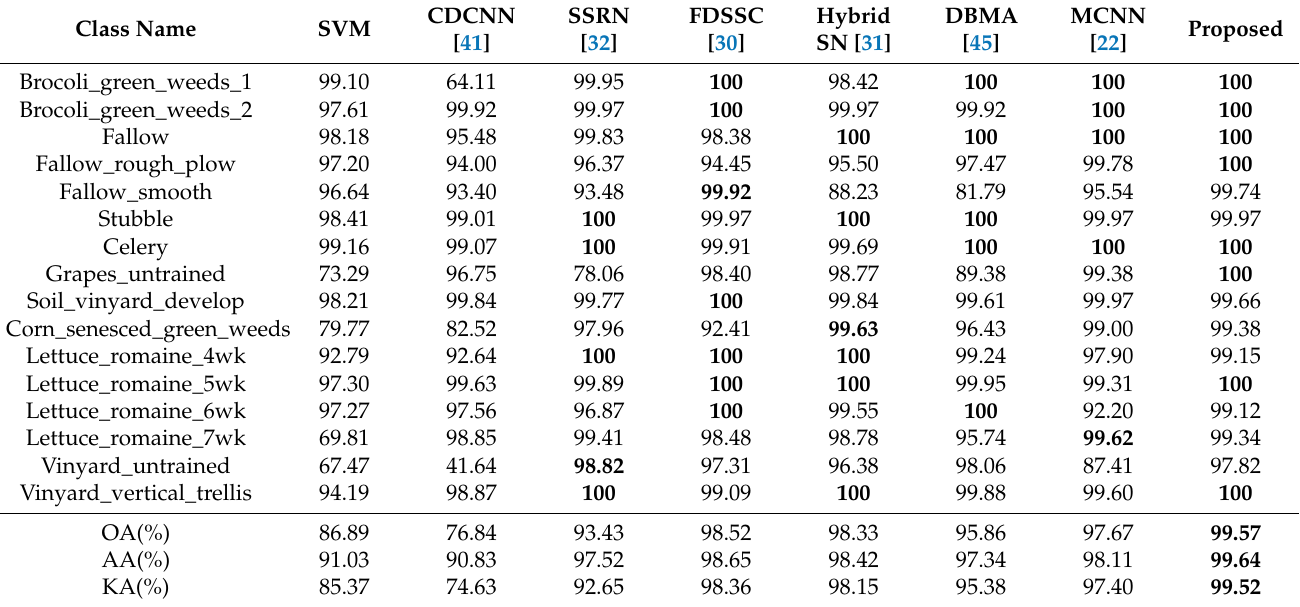
Table 7. Classification result of different methods on the SA